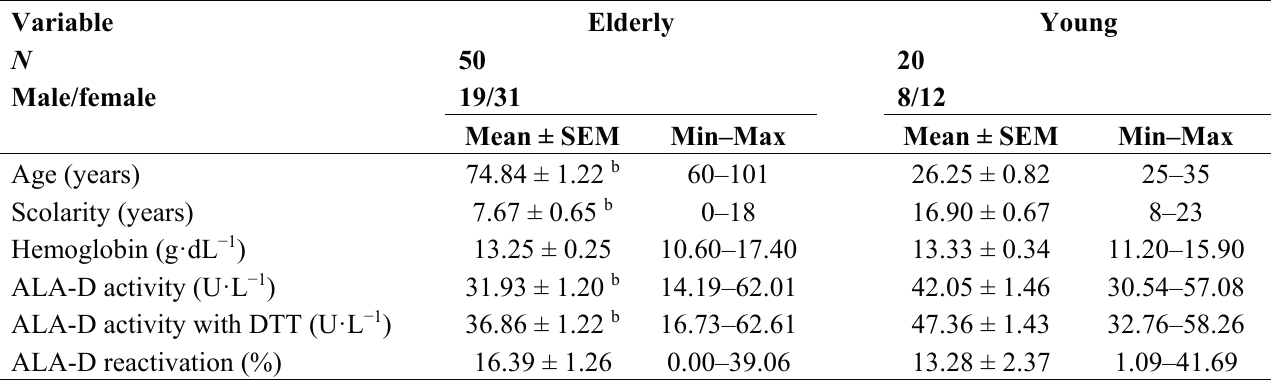
Table 1. Characteristics of the study